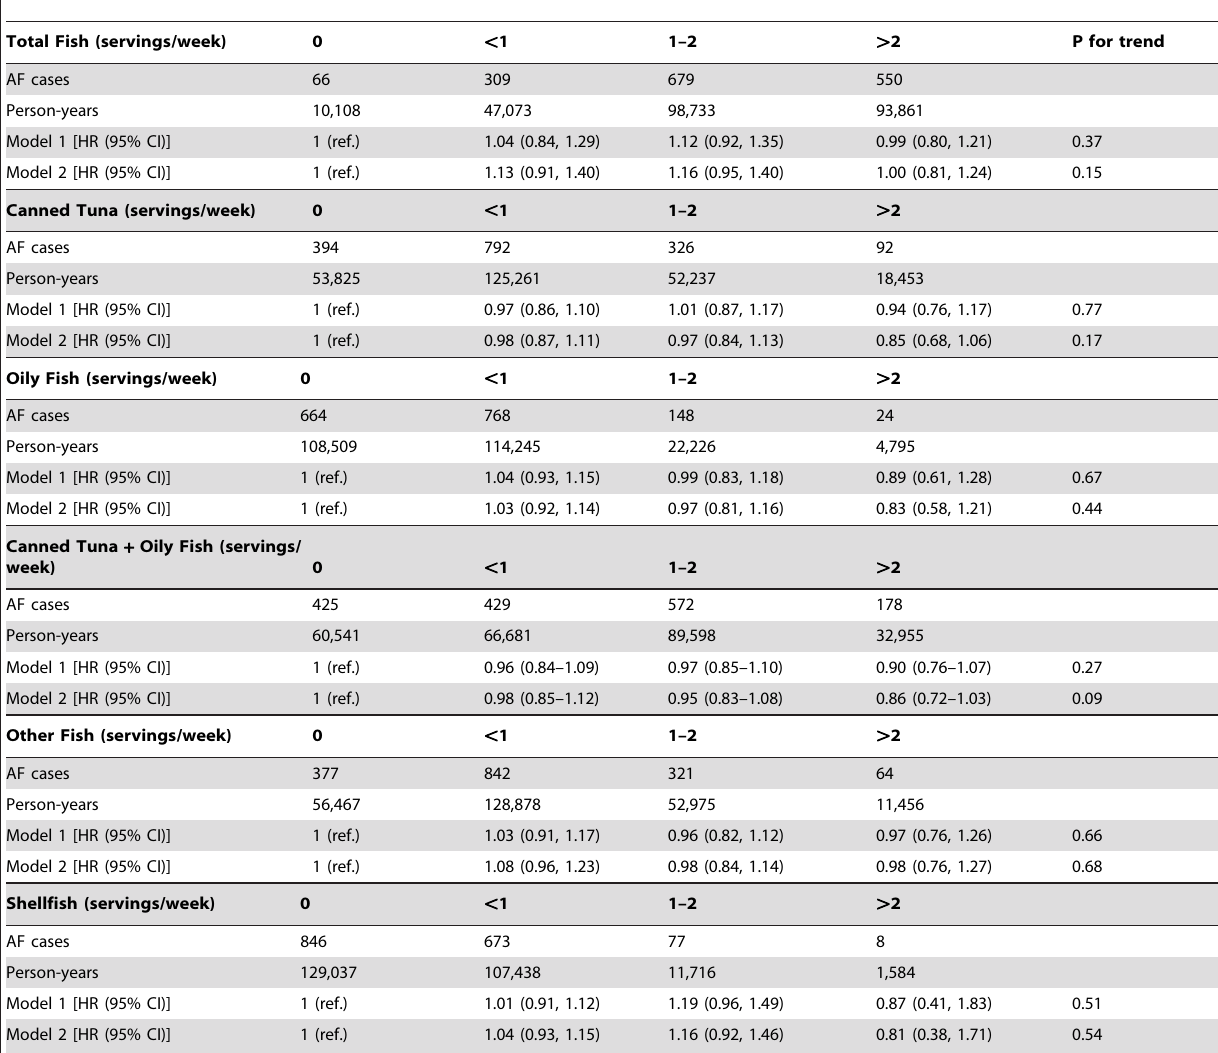
Table 2. Hazard ratios (95% confidence intervals) of atrial fibrillation by fish intake categories, ARIC, 1987–2008.